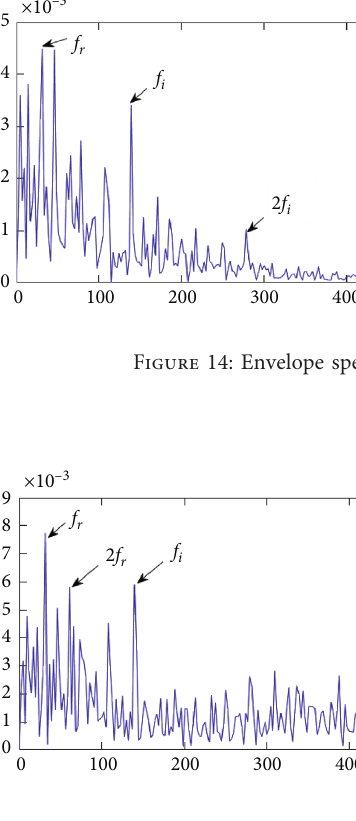
Figure 15: Envelope spectrum of sensitive IMF component by EMD